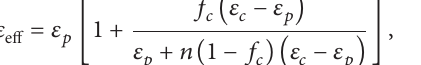
Figure 6: Variation of effective dielectric constant ( 𝜀 various